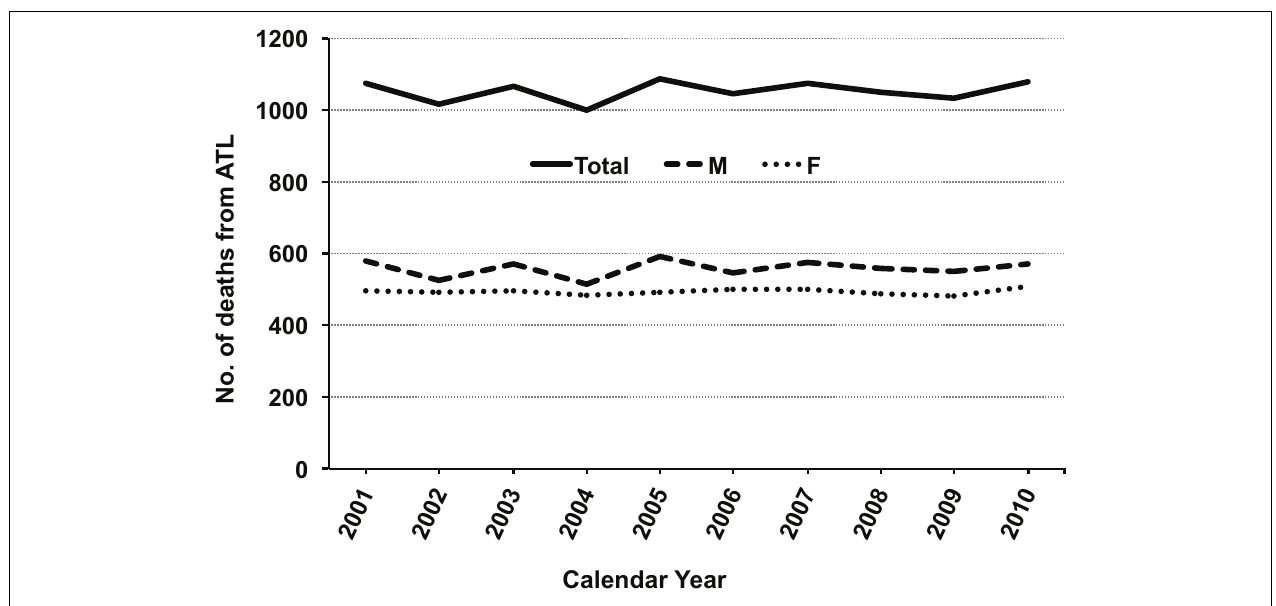
FIGURE 1 |Annual number of deaths from adultT-cell leukemia (ATL) during 2001–2010 in Japan. The raw data were obtained from vital statistics in the Portal Site of Official Statistics of Japan (e-Stat; accessed April 8, 2012). Abbreviations: M, male; F, female.